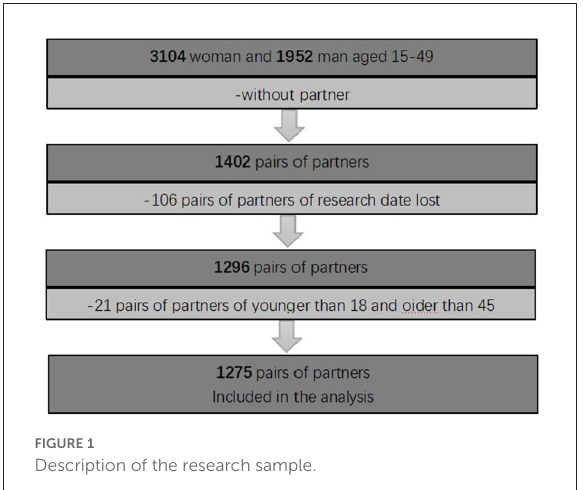
FIGURE1 Description of the research